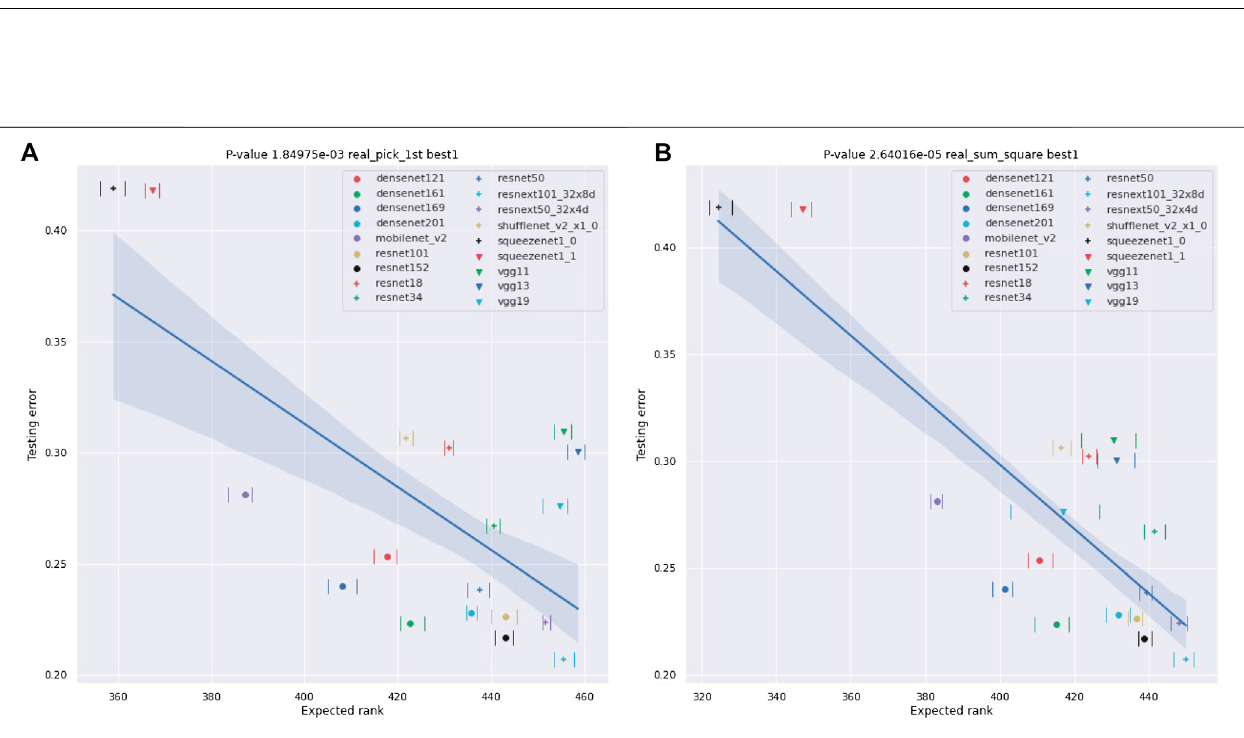
FIGURE 11 | Plots of the best-1 testing error of NNs against their ESD. As in Figure 9 , the testing errors are as provided by [30] and are error rates for testing on ImageNetcropimages. WealsoprovidetherangeoftheESDover10differentexperimentsusinganimagefromtheImageNetdatasetforeach x ,and,again,theranges are small relative to the differences between the various networks, though somewhat larger than in the x ∈ {− 1 , 1 } 3 × 224 × 224 . Also in this case, the ESD shows a strong negative correlation with the best-1 error. It is interesting to note that the ranges of the ESD for each NN are larger in this case than in 9 and 10. We conjecture that thisisbecauseofthelargerdiversityoftheImageNetdataset.However,the p -valuesarestillquitesmall,eveninthiscase.Thecon fi denceboundsonthelinear fi tareone- σ bounds based on 1,000 bootstrap samples.